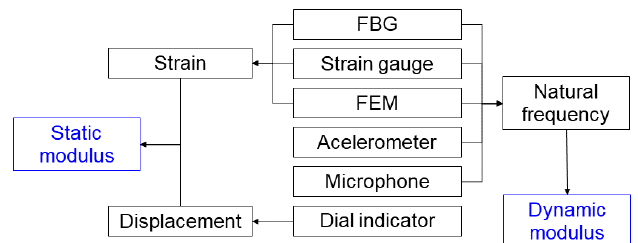
Figure 5. Evaluated techniques flowchart